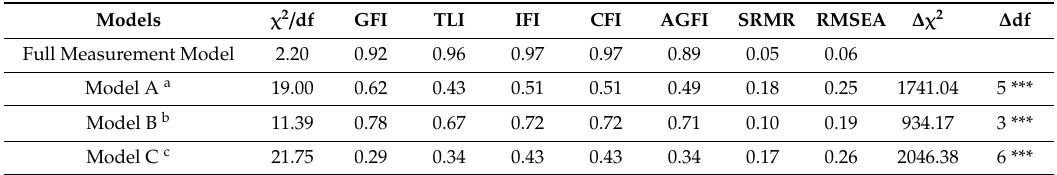
Table 4. Summary of model fit indexes.